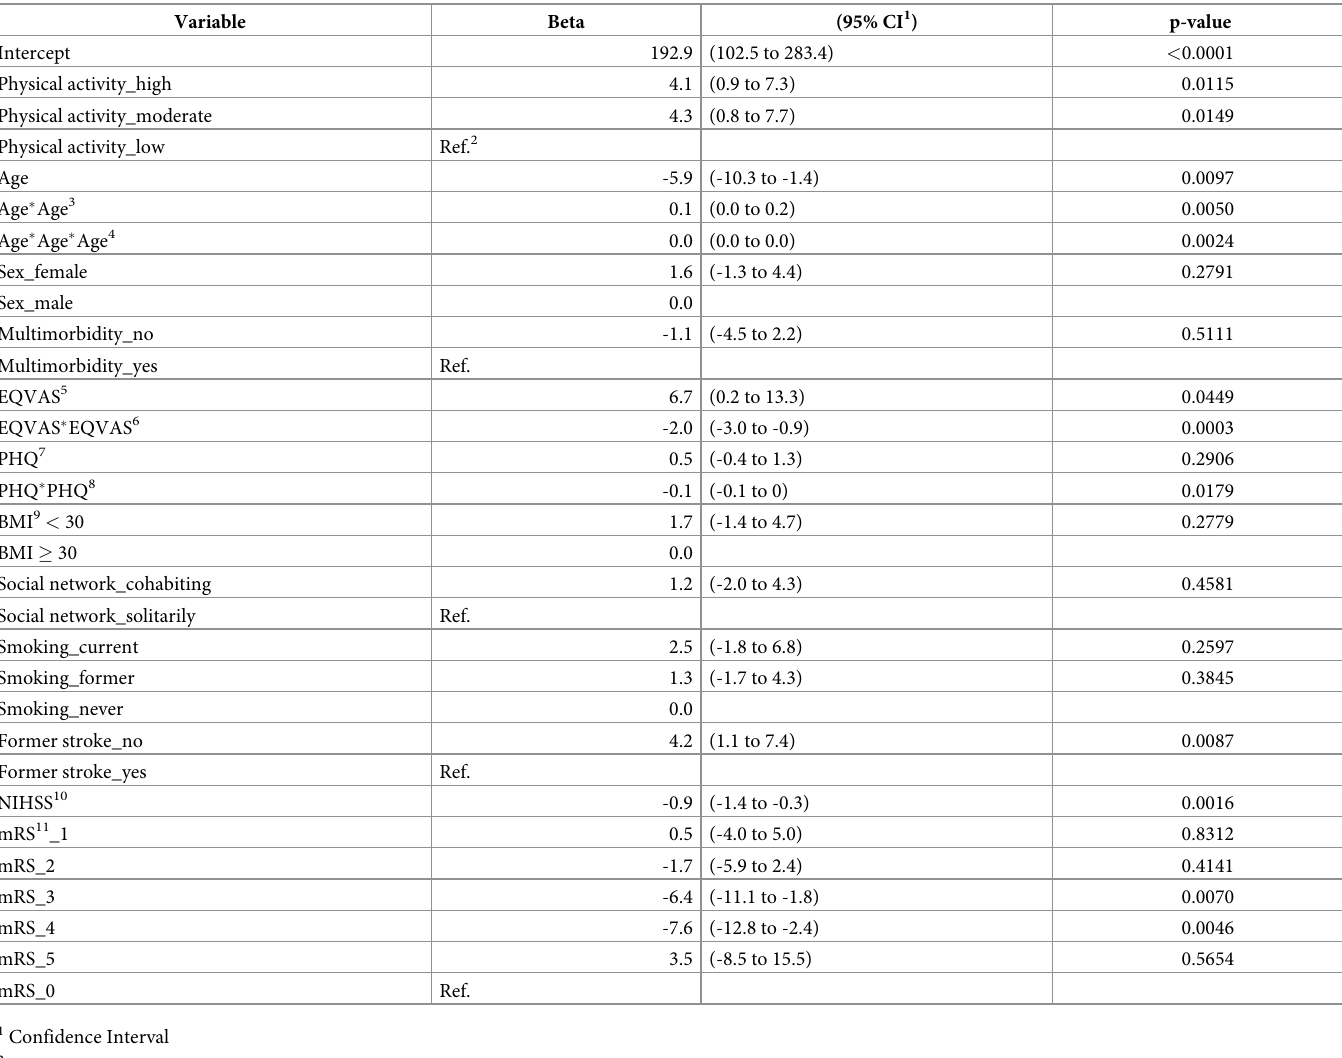
Table 3. Associations between pre-stroke physical activity and physical quality of life after three months: Results of the multiple linear regression